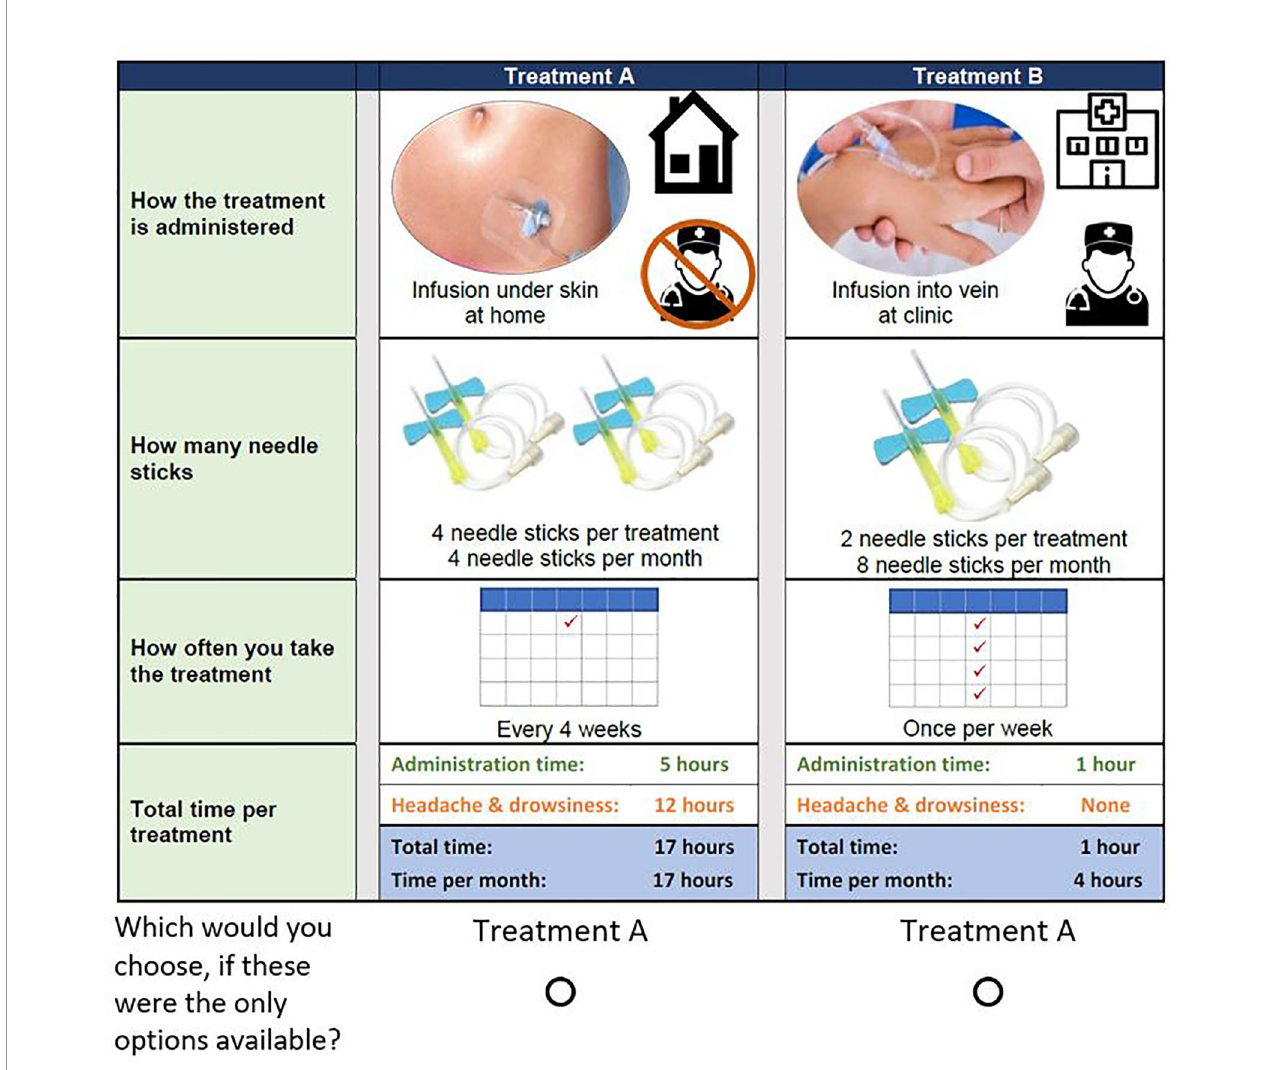
FIGURE 1 | Example DCE choice question. Example question answered by study participants. Respondents were asked to answer 14 of these questions, each with different combinations of levels for each treatment